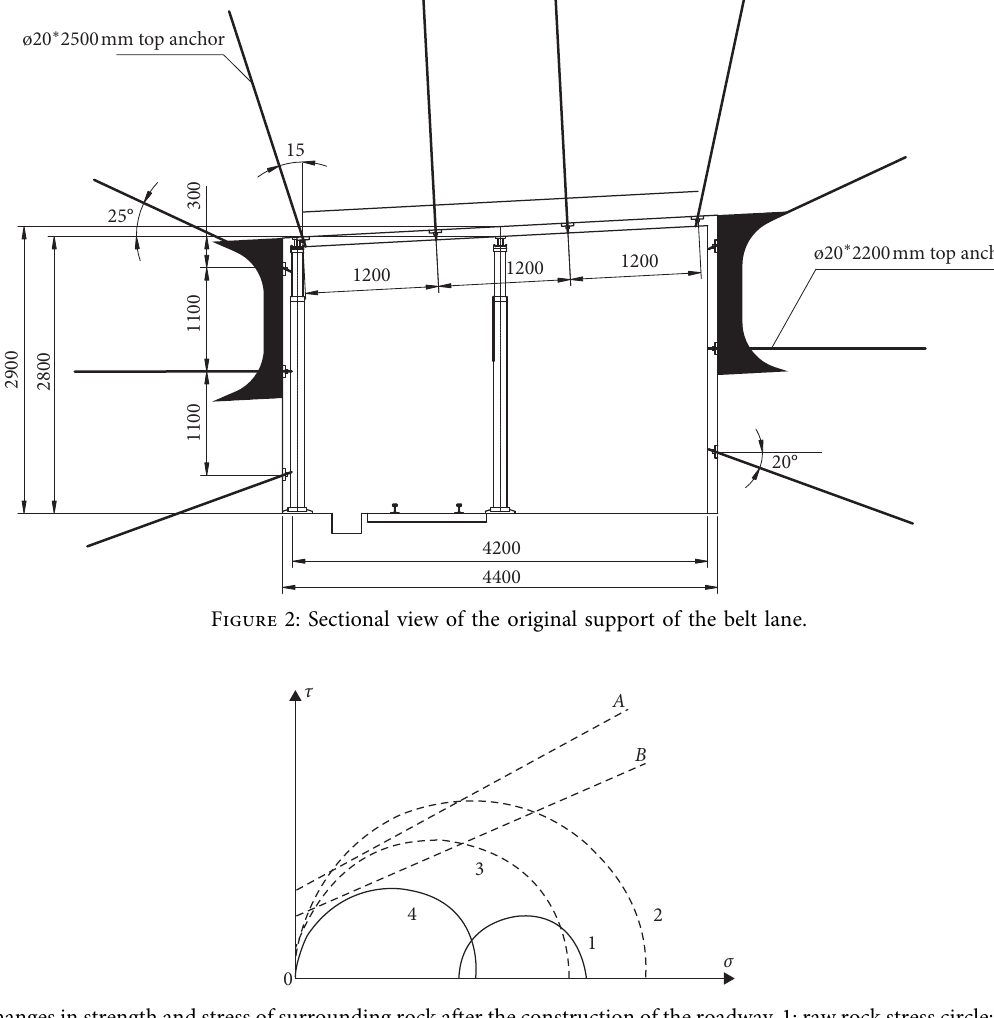
Figure 3: Changes in strength and stress of surrounding rock after the construction of the roadway.1: raw rock stress circle; 2: deformation circle after roadway construction; 3: stress circle after roadway construction; 4: stress circle after roadway construction is stable; A: envelope line after roadway construction; B: long-term roadway stability package